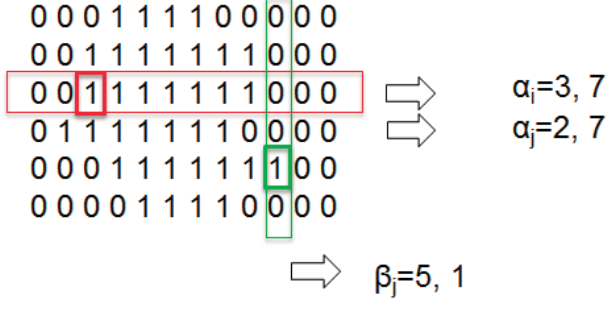
Figure 10. Line-based Image Coding with